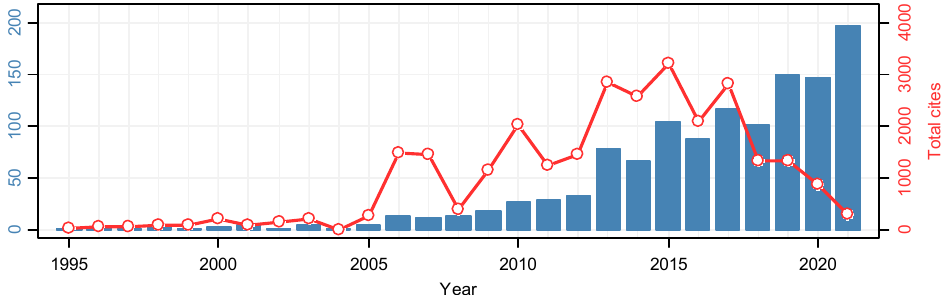
Figure 1. The annual number of WOS papers related to offshore wind farm research that were published (blue bars) and cited (red line).